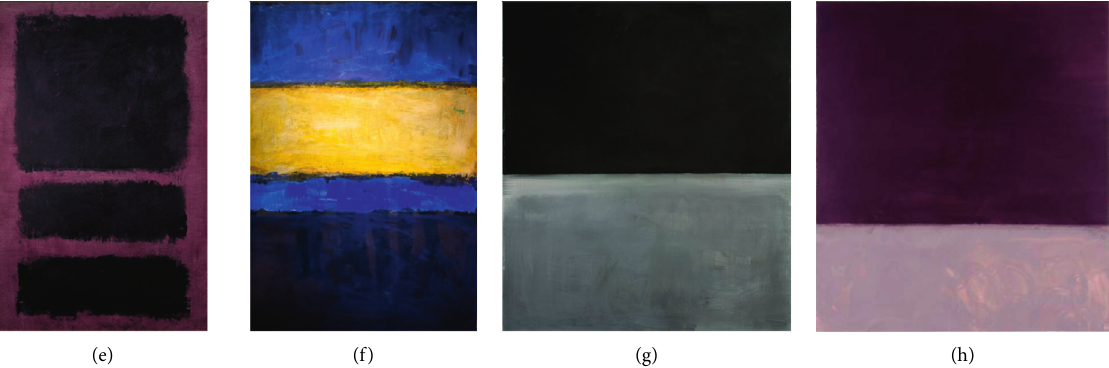
Figure 24: Mark Rothko’s dark Color Field Painting artwork. (a) No. 2, 1964. (b) No. 8, 1964. (c) Untitled, 1967. (d) Untitled (Gray, Gray on Red), 1968. (e) Untitled, 1968. (f) Untitled, 1968. (g) Untitled, 1969. (h) Untitled (Black and Gray),